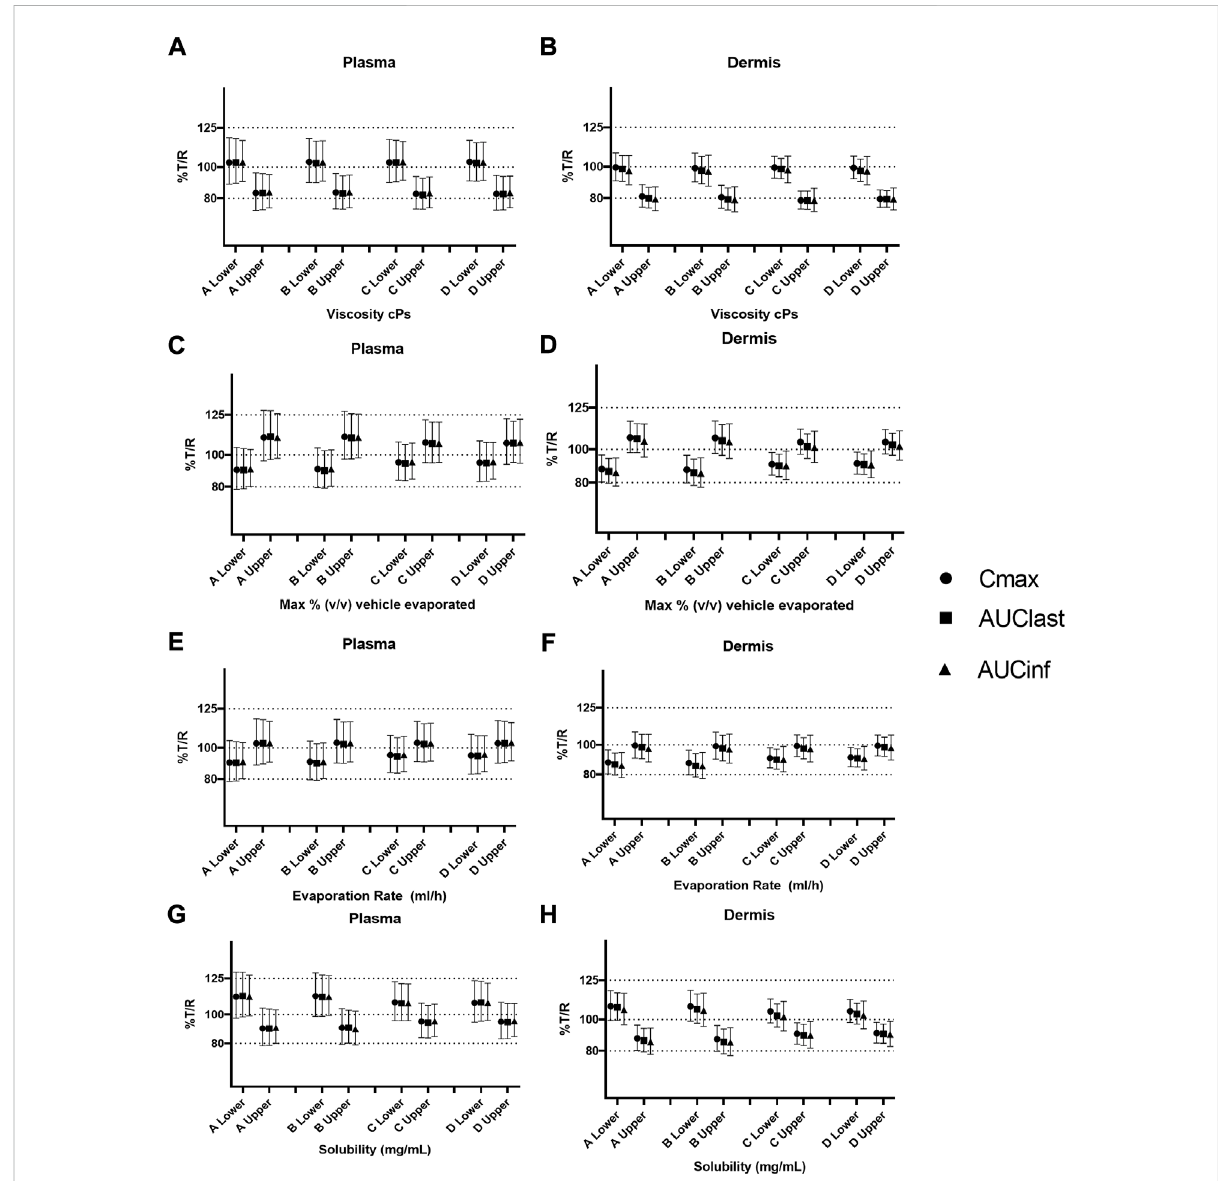
FIGURE 7 Sensitivity analysis of formulation parameters in alternate physiology conditions; viscosity (A,B) , % v/v volatile fraction (C,D) , evaporation rate (E,F) , and solubility (G,H) for physiology scenarios (A – D) . The “ lower ” and “ upper ” represent the lower and upper bound values for each formulation parameter,